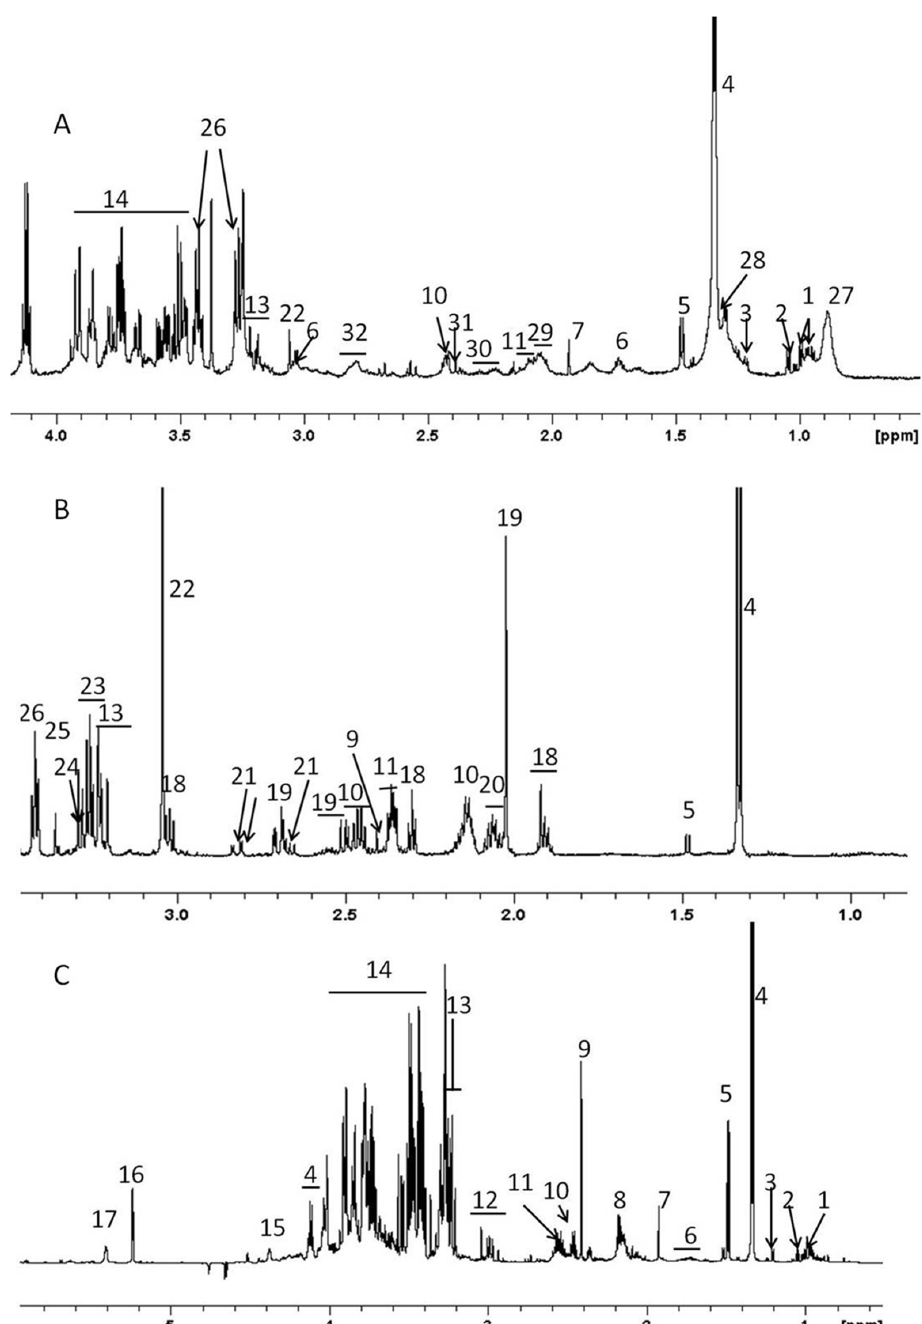
Figure 2. Representative 700 MHz 1 H NMR spectra of hydrophilic fraction of methanol/water/chloroform extract. (A) serum, (B) brain and (C) liver from healthy uninfected mouse. Only aliphatic region of the spectra is shown. 1- Isoleucine/Leucine, 2- valine, 3- 3-hydroxybutyrate, 4- lactate, 5- alanine, 6- lysine, 7- acetate, 8- glutamate/glutamine, 9- succinate, 10- glutamine, 11- glutamate, 12- aspartate + lysine, 13- N + (CH 3 ) 3 head groups from GPC, PC and choline, 14- carbohydrates, polyols and amino acid a´ - 1 H, 15- N-methylnicotinamide, 16- anomeric 1 H of a´ -glucose, 17- glycogen, 18- c -aminobutyric acid, 19- N-acetylaspartate, 20- glutamate + N-acetylneuraminate, 21- aspartate, 22- creatine, 23- taurine + myo-inositol, 24- myo-inositol, 25- scyllo-inositol, 26- taurine, 27- lipid (LDL/VLDL- CH3(CH2)n),28- fucose, 29- lipids (CH2-C=C), 30- lipids (CH2-C=O), 31- oxaloacetate/pyruvate, 32-=C-CH2-C=. doi:10.1371/journal.pone.0066954.g002 system installed with a Bruker AVANCE 700 MHz NMR (including the shimming and tuning/matching of the probe) and spectrometer, fitted with a broad band inverse probe (Bruker processed using the ICON NMR automation software. The pulse Biospin, Karlsruhe), the temperature of the probe was maintained program used was the first trace of the NOESY (Nuclear at 298 K during the experiments. 1 H NMR spectra were acquired Oherhauser Effect SpectroscopY) experiment which takes the